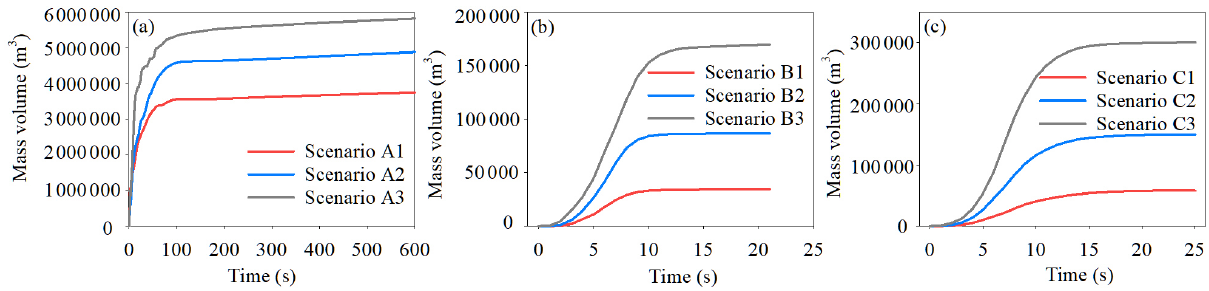
Figure 5. Volume of material entering Bienong Co for different (a) ice avalanche scenarios and (b) and (c) landslide scenarios.